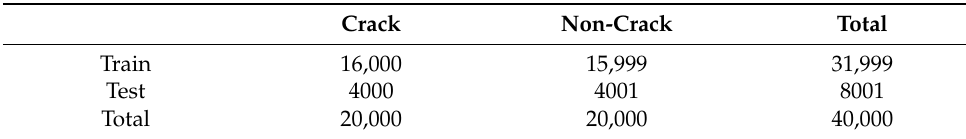
Table 1. Dataset Test-train